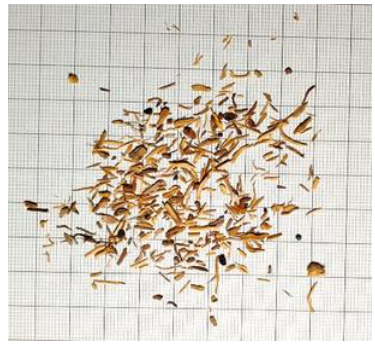
Figure 10. Krameria lappacea roots.